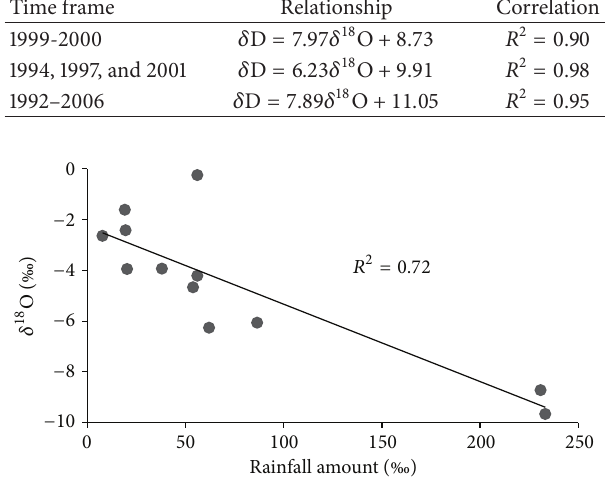
Figure5:Relationshipbetweenyearlyweightedrainfallamountand 𝛿 18 O of